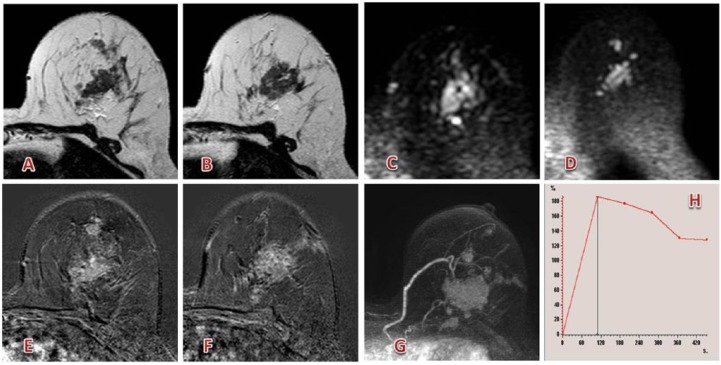
Multicentric right breast lesion (greater than ~1 cm) in the upper-outer quadrant with irregular margins, restricted diffusion, and strong enhancement (infiltrative ductal carcinoma). (A-C) Postcontrast and subtracted images; (D, E, F, G) diffusion-weighted images; (H) enhancement curve. Contrast agent: gadobutrol, 8 mL. Courtesy of Professor De Cobelli, Radiology Department, San Raffaele Scientific Institute, Milan.